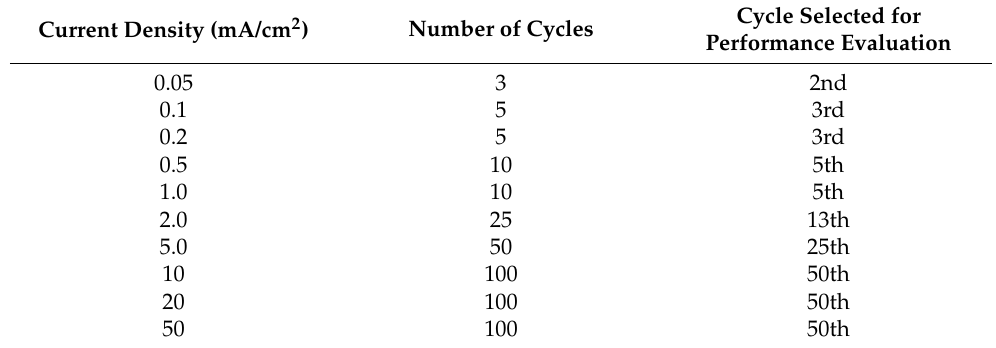
Table 2. Rate test sequence for performance evaluation of three-electrode LIC